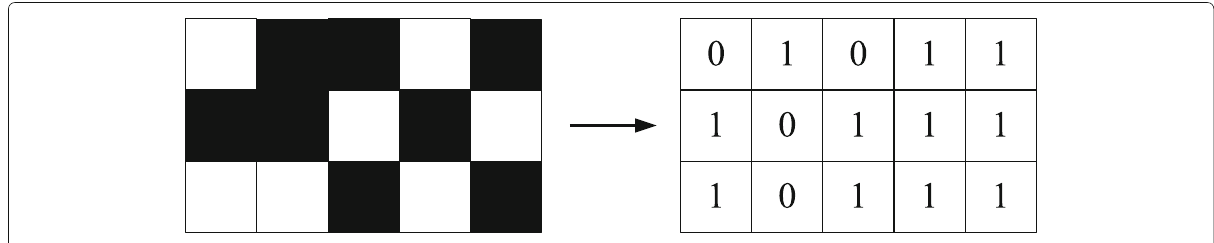
In the difference matrix domain, four continuous bits form one pattern . Therefore, there exist sixteen patterns, from D0000 to D1111. These patterns are denoted as P0 to P15 or P0000 to P1111. The embedding procedure is as follows. First, the PS method transforms an image to the difference matrix domain by Eq 1, and then two specific patterns are cho-